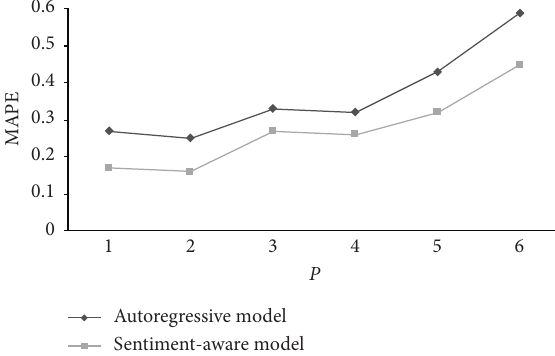
Figure 4: Result of comparative